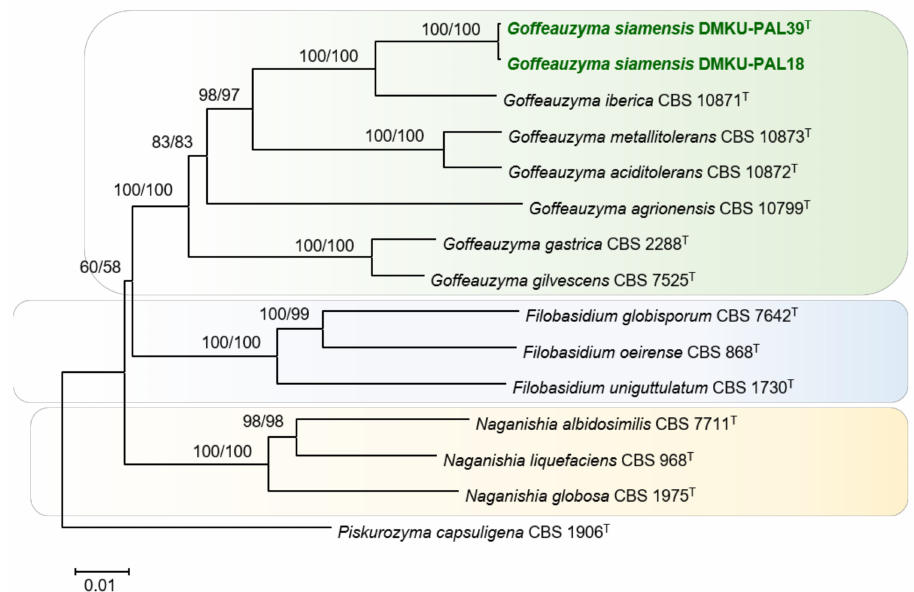
Figure 4. Phylogenetic tree of Goffeauzyma siamensis sp. nov. based on the concatenated sequences of the SSU rRNA, ITS regions, D1/D2 domains of the LSU rRNA, RPB2 and TEF1 genes showing positions of the three strains of a novel species with respect to closely related species. The tree backbone was constructed with the neighbor-joining method by MEGA software. Numbers at the node indicate percentages of bootstrap sampling (BP) of the NJ and ML analyses, derived from 1000 samples. All positions containing gaps and missing data were eliminated, resulting in a total of 2123 positions in the final dataset. Piskurozyma capsuligena CBS 1906 T was used as outgroup in these analyses. Bar, patristic distance of